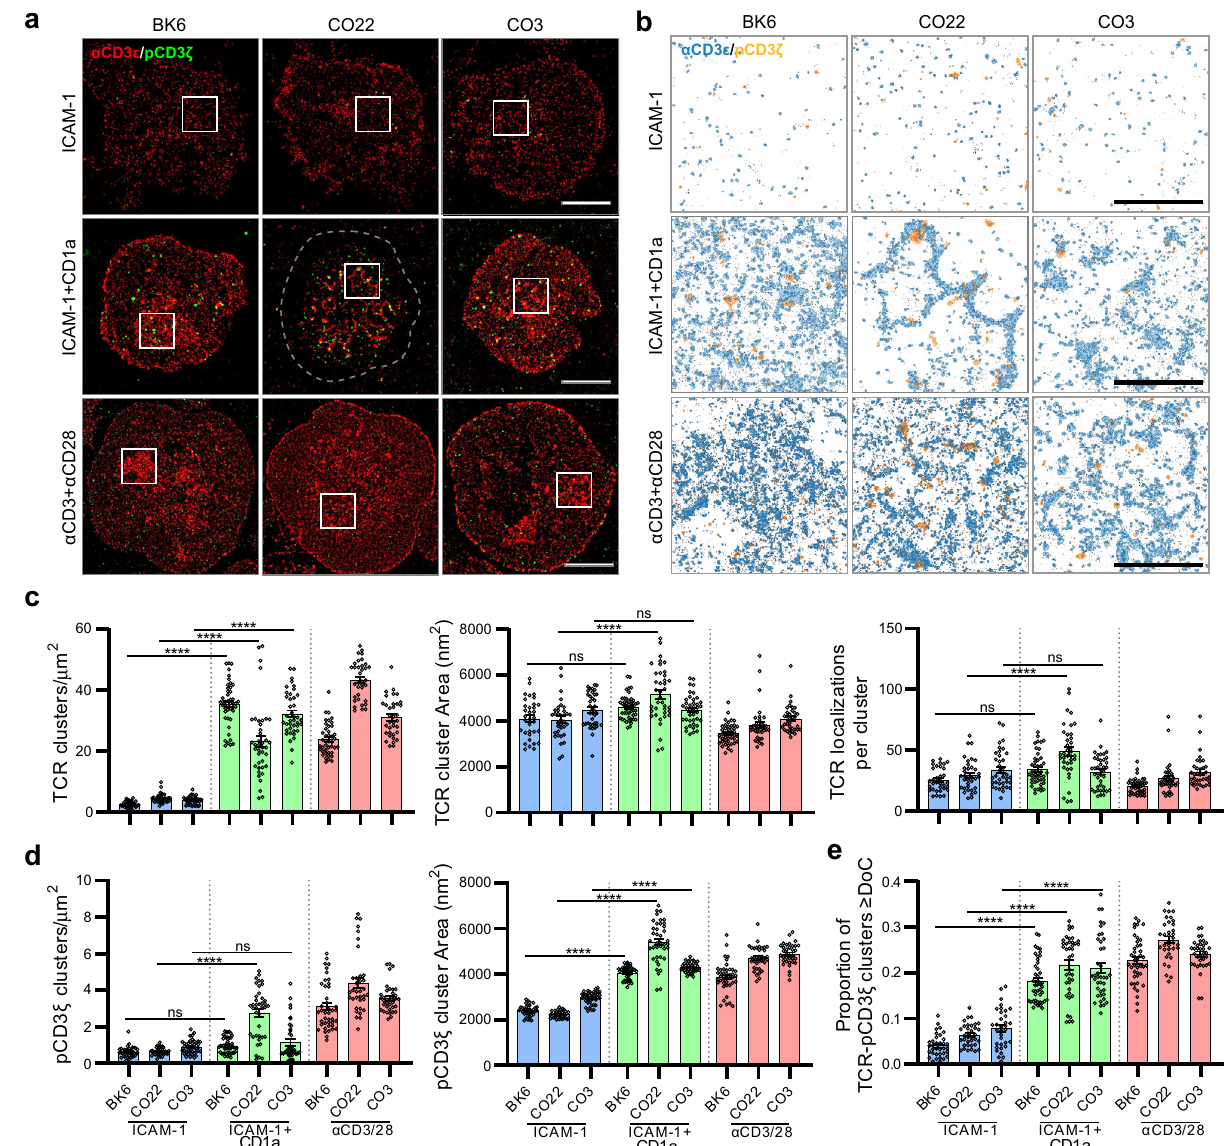
Fig. 7 CD1a-induced γδ TCR clustering and signalling. a Dual-colour single-molecule localisation microscopy images of CD3 ε (red) and pCD3 ζ (green) in Jurkat T cells expressing CD1a-reactive BK6, CO22 and CO3 TCRs triggered on supported lipid bilayer decorated with ICAM-1, ICAM-1 + CD1a or anti- CD3/CD28 antibodies under 5 min. Scale bar 5 µ m. b Closeup view (4 × 4 µ m) of cluster maps generated through DBSCAN analysis based on representative regions (boxed) from the corresponding single-molecule localisation microscopy images. Pseudo coloured CD3 ε and pCD3 ζ clusters are shown in blue and orange respectively. Localisations outside the threshold of clustered organisation are indicated in black dots. Scale bar 2 µ m. c , d CD3 ε and pCD3 ζ clustering was quanti fi ed by DBSCAN analysis and the degree of CD3 ε -pCD3 ζ colocalisation analysed with DoC thresholding and reported as proportion of colocalised clusters e . Analysis was performed across n ≥ 30 single T cells which includes at least three independent replicates. Statistical signi fi cance determined by one-way ANOVA; ns, not signi fi cant; * P ≤ 0.05; ** P ≤ 0.01; *** P ≤ 0.001; **** P ≤ 0.0001. The exact values of the P values are shown in Supplementary Table 4. Error bars represent the SEM. Source data are provided as a Source Data fi le.